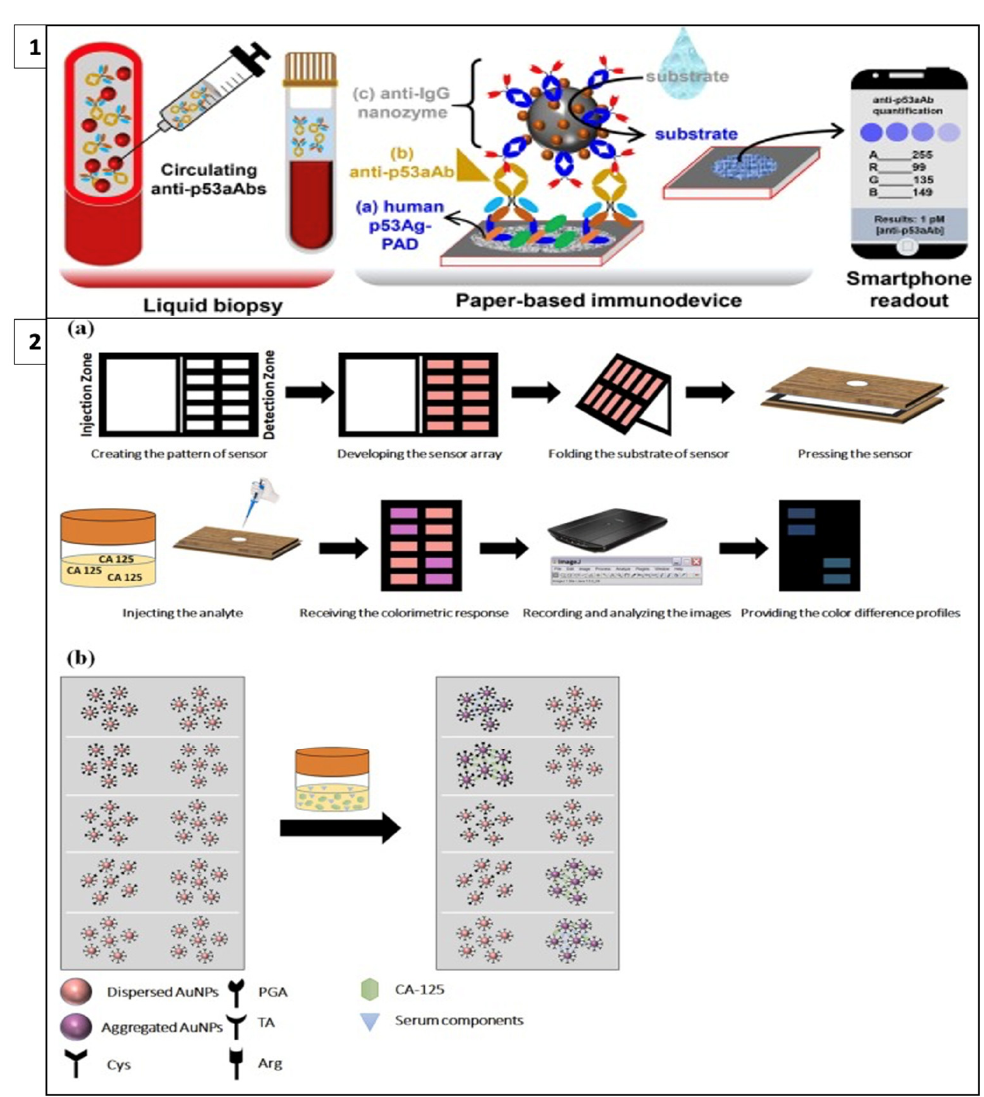
Figure 4. ( 1 ) Detection of tumor-specific anti-p53 autoantibodies (anti-p53aAbs) (reprinted with permission from [104]; copyright 2022, Elsevier); ( 2 ) colorimetric cancer detection system called fingerprint response model (a) fabrication and application of the proposed sensor array and (b) interaction of sensor components and CA-125 cancer marker. (reprinted with permission from [105]; copyright 2022,